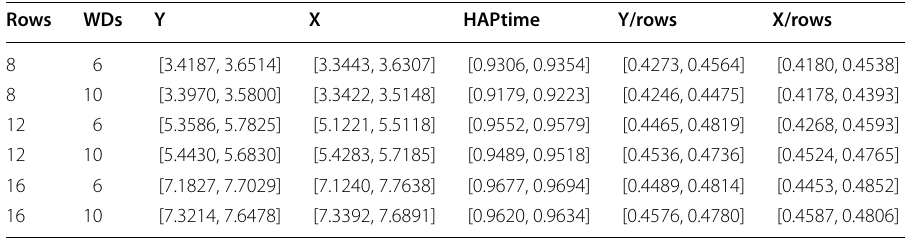
This table describes the 95% confidence interval of some variables from the experimental results using test dataset, are same to as Tables 3 and 4